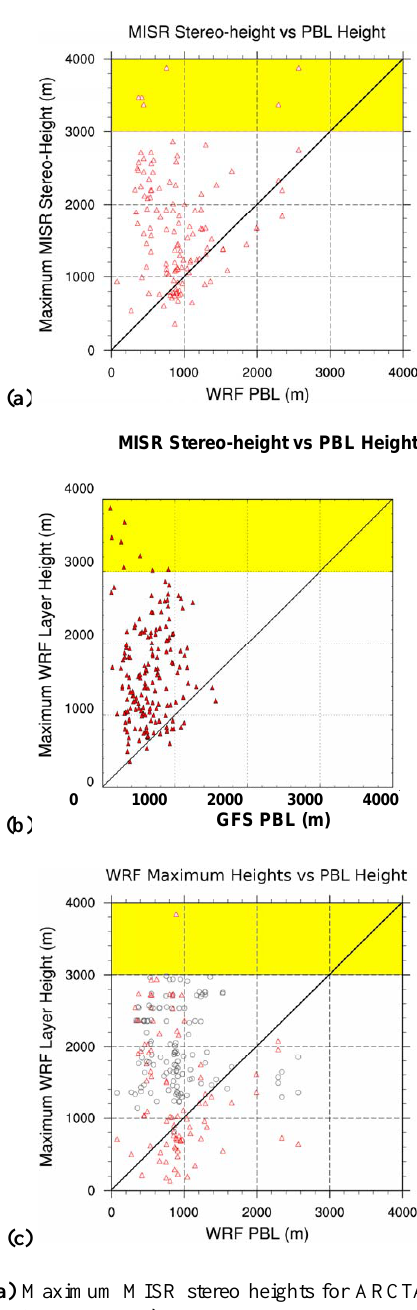
Fig. 6. (a) Maximum MISR stereo heights for ARCTAS plumes (see Fig. 2c for an example) plotted against PBL heights from WRF- Chem. (b) As in panel (a) , but plotted against PBL heights from GFS, (c) maximum simulated injection heights for PC PLR (black circles) and FB PLR (red triangles) plotted against PBL heights heights from WRF-Chem. Points above the diagonal in (a) and (b) represent MISR injections above the simulated PBL. The yellow shaded region represents the lower half of the injection layer for the 35K simulations. Injections occur uniformly in the 35K layer; thus, the maximum injection height is at 5km. Injection from PLR occurs in a layer determined by the 1-D plume model. The top of this layer (the maximum height is shown in (c)